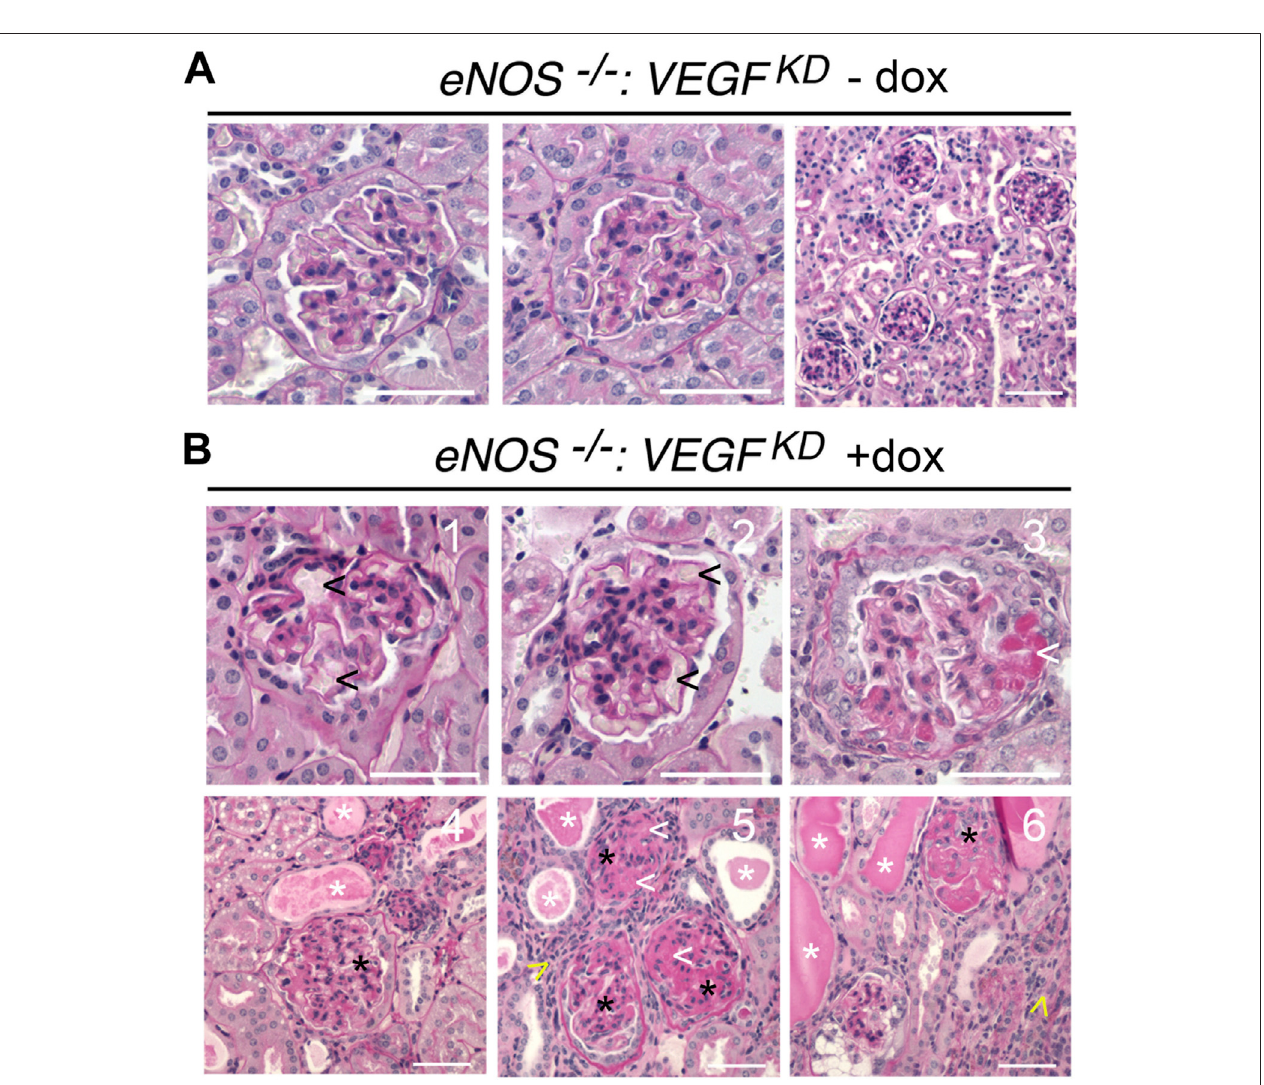
FIGURE2| Histologyof eNOS − / − :VEGF KD kidneysrevealsdiffuseglomerulosclerosisandmimicsadvancedDKD:PASstainrepresentativeimages: (A) eNOS − / − :VEGF KD − dox glomeruli are normal by light microscopy; (B) eNOS − / − :VEGF KD + dox glomeruli show microaneurisms (1-2, black arrowheads), mesangiolysis (3,5,6, white arrowheads), mesangial expansion(Papapetropoulosetal.,1997;Shenetal.,1999;Reidyetal.,2014;Tuttleetal.,2014),severemesangialsclerosis(4-6,black asterisks),proteinaceoustubularcasts(4-6, white asterisks) and lymphocytic in fi ltrates (5 – 6, yellow arrowheads); Scale bars = 50 μ m (A, B1-3) and 100 μ m (B4-6) ; PAS: Periodic acid-Schiff stain.